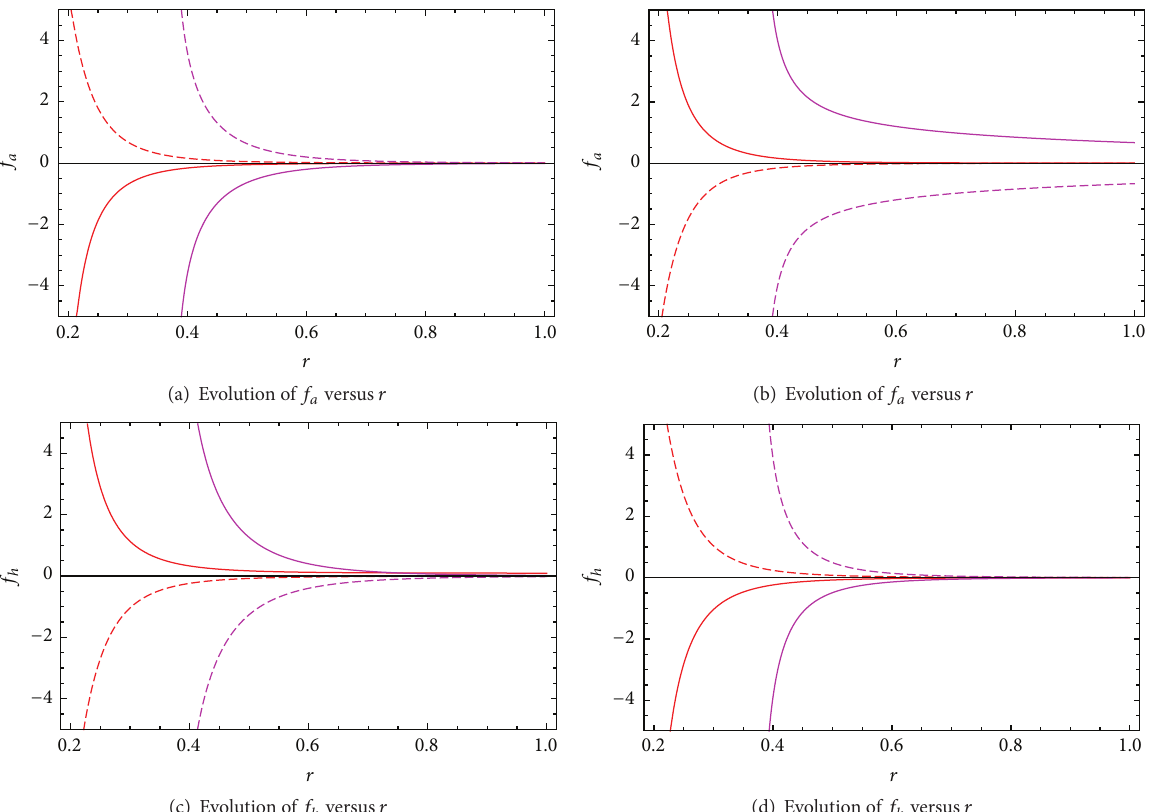
Figure 9: Plots of (a) 𝑓 𝑎 for 𝑠 + , (b) 𝑓 𝑎 for 𝑠 − , (c) 𝑓 ℎ for 𝑠 + , (d) 𝑓 ℎ for 𝑠 − versus 𝑟 with Gaussian distribution for 𝑛 = 5 , 𝜖 = 1 (red), 𝑛 = 5 , 𝜖 = −1 (red dashed), and 𝑛 = 6 , 𝜖 = 3 (purple).